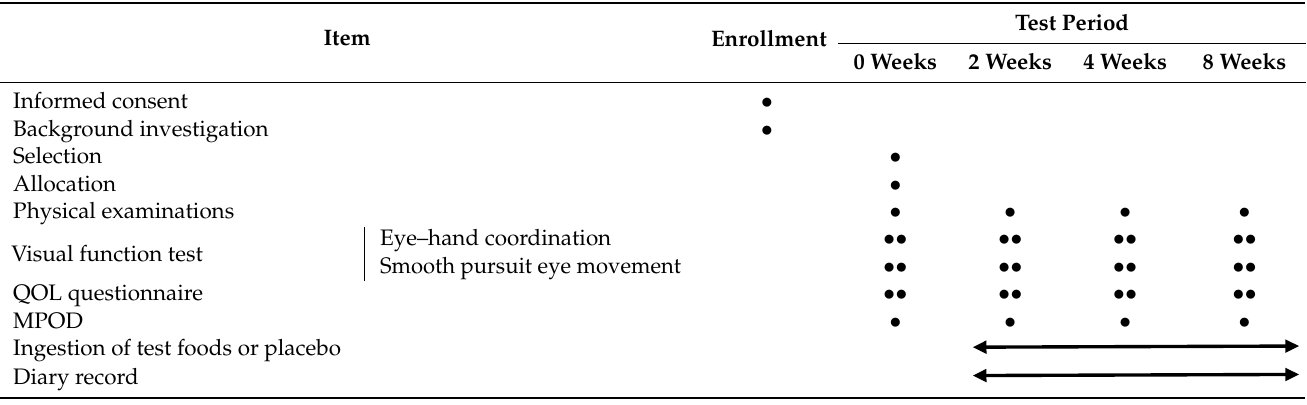
Table 1. Schedule of enrollment, intervention, and